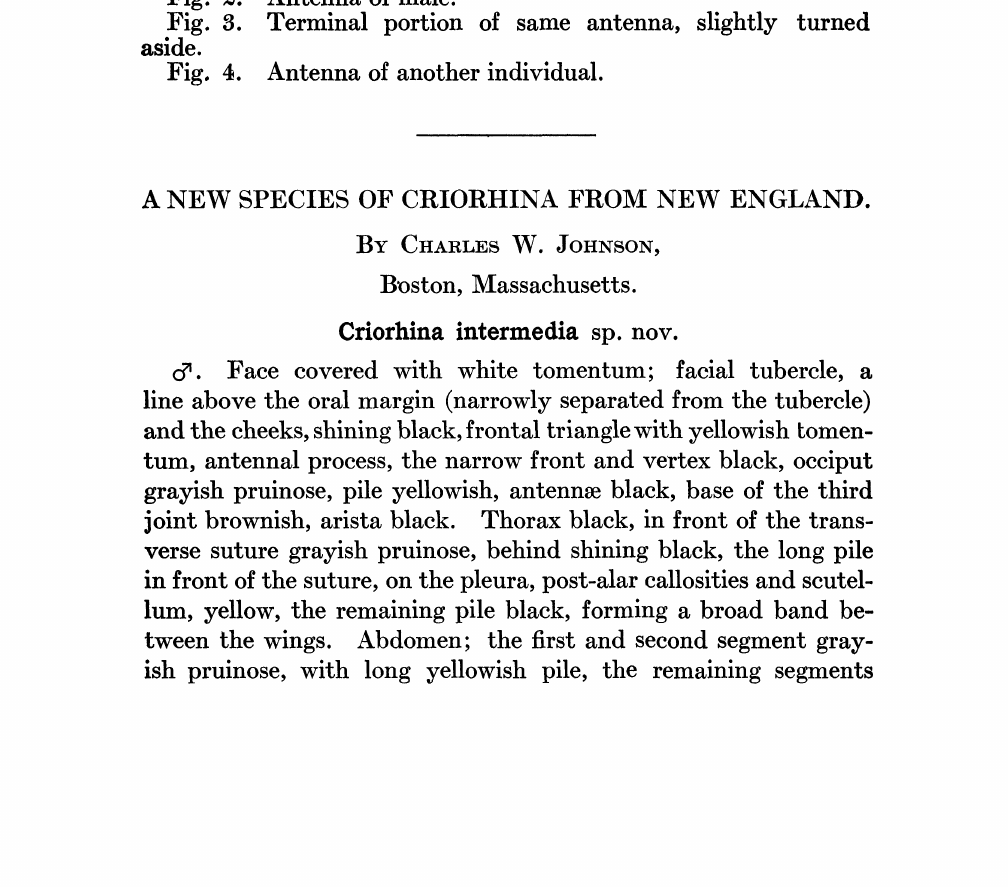
EXPLANATION OF FIGURES. Plate VIII. Chonea alpna Bezzi, male, dorsal view. Ventral side of another individual, male. Head of male, lateral view. Ovipositor,of female, dorsal view. Plate IX. Chionea alpina, male, habitus. (Freshly killed